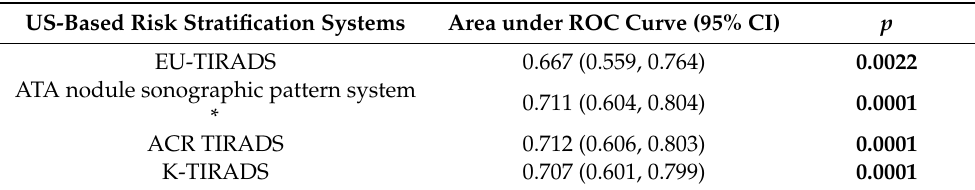
Figure 2. Receiver operating characteristic (ROC) curves of four ultrasonography-based risk stratification systems to predict thyroid malignancy in nodules with nondiagnostic or unsatisfactory cytopathological results. Table 5. Area under the receiver operating characteristic curve of ultrasonography-based risk stratification systems to predict thyroid malignancy in nodules with nondiagnostic or unsatisfactory cytopathological